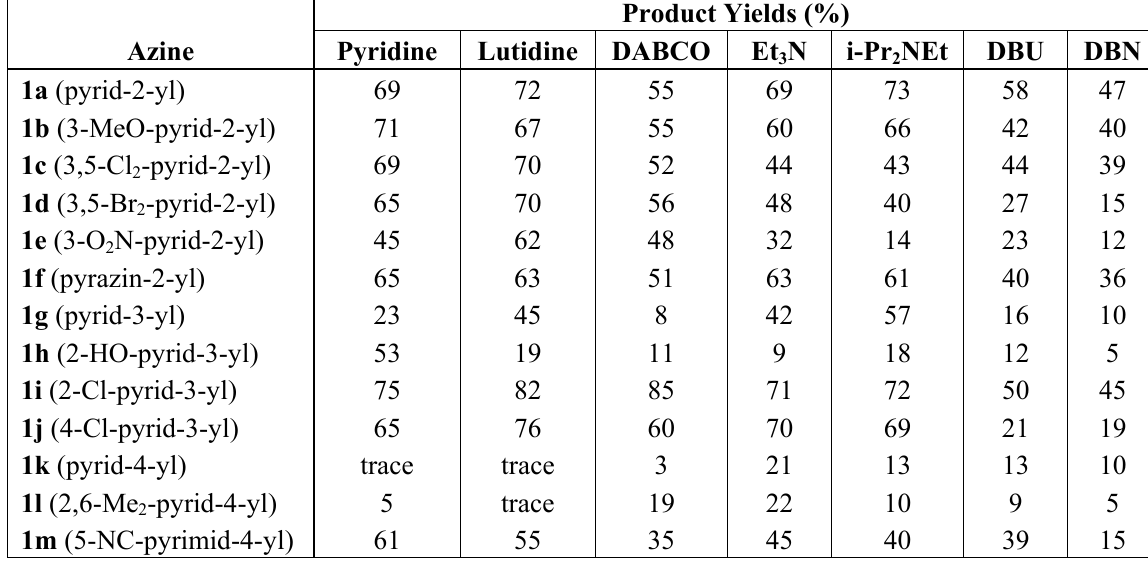
Table 2. Reaction of 4,5-dichloro-1,2,3-dithiazolium chloride 4 (2.18 mmol)